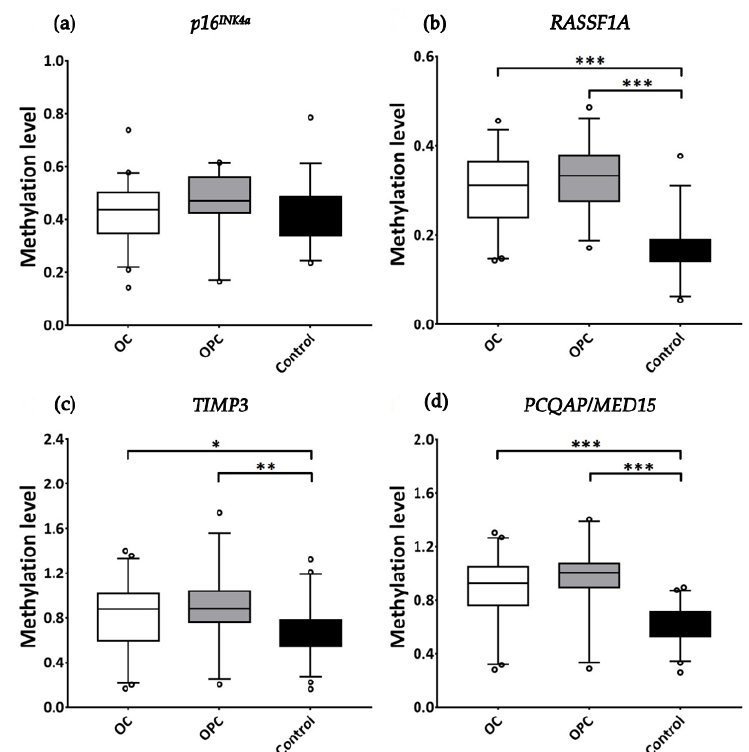
Figure 3. Hypermethylation profiles of individual TSGs among OC, OPC, and normal healthy control cohorts. Whisker-box plots were drawn (on 5–95% percentile) for the methylation signatures of ( a ) p16 INK4a , ( b ) RASSF1A , ( c ) TIMP3 , and ( d ) PCQAP / MED15 in the saliva collected from OC patients ( N = 54), OPC patients ( N = 34), and normal healthy controls ( N = 60), analyzed using Mann–Whitney U test. Significant difference in the promoter methylation level between two cohorts is marked with * p < 0.05, ** p < 0.001, or *** p < 0.0001.